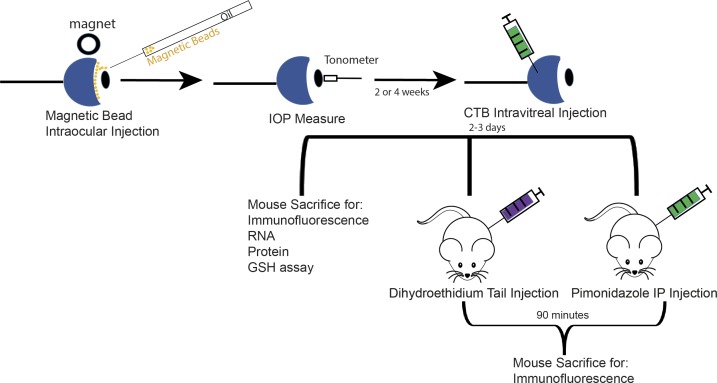
Experimental design. OHT was induced by magnetic bead intracameral injection. IOP was measured before OHT (baseline), day 1 after induction, then once weekly for 2 or 4 weeks. CTB intravitreal injection was performed 2 to 3 days before animals were killed to determine integrity of anterograde axon transport. One group of mice received an IP injection of 60 mg/kg pimonidazole, then was killed 90 minutes later, to assess hypoxia at 2 and 4 weeks after OHT. A separate group of mice received a tail vein injection of DHE, then was killed 90 minutes later to determine superoxide level 4 weeks after OHT. Separate groups of mice were killed for protein, RNA, and GSH analysis. Sample sizes are listed in Supplementary Table S1.